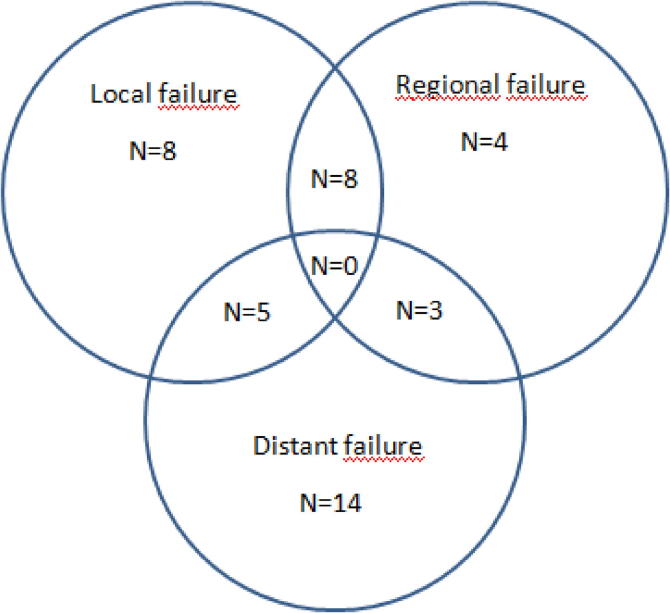
Venn diagram of failure.